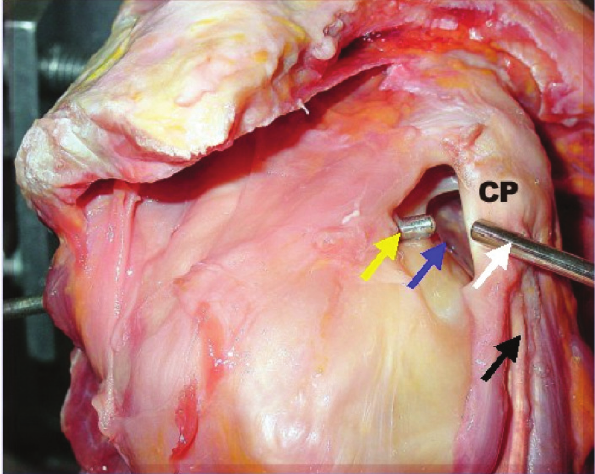
Figure 5 - Right shoulder: CP (coracoid process); transarticular access for the optics through the posterior portal (yellow arrow); subcoracoid space (blue arrow), anterior portal for shaver access (white arrow); musculocutaneous nerve (black arrow)